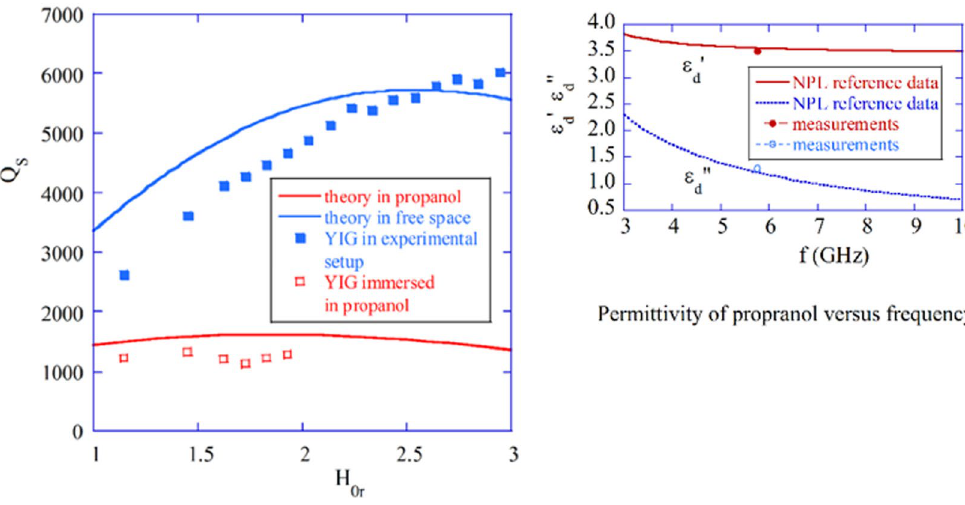
Figure 6. YIG sphere in the free space and immersed in propanol. Computed and measured Q-factors due to the magnetic, dielectric and radiation losses versus H 0r for the YIG sphere in the free space and in propanol. Computations were performed for R 1 = 0.25 mm, ∆ = .